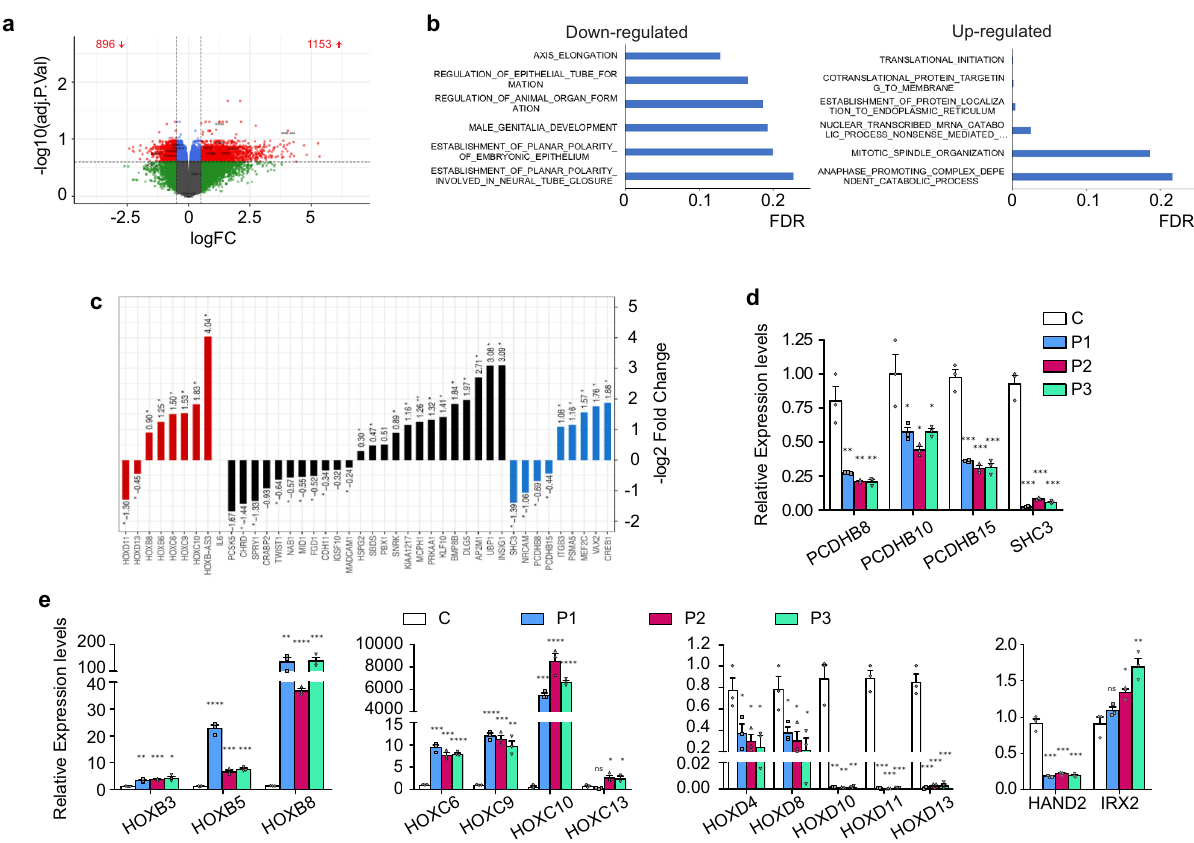
Fig. 3 Genes involved in development and differentiation are deregulated in CdLS patient-derived cells. a Volcano plot representation of gene expression changes between control and CdLS-derived fi broblasts. Signi fi cantly downregulated and upregulated genes are indicated in red. Green, blue, and gray show non-signi fi cant differential genes. b Gene ontology (GO) enrichment analyses reveal biological processes that are downregulated and upregulated in CdLS-derived fi broblasts (blue bars). c Representation of the log-fold changes in expression of genes related to developmental processes (black bars). Genes involved in embryonic system development and differentiation are marked in red, those involved in nervous system development are marked in blue. Two-sided unpaired student ’ s t -test (** p < 0.01; * p < 0.05). d , e The expression levels of some nervous system development genes ( d ) and embryonic development genes ( e ) were analyzed in a control (C, white) and three CdLS patient-derived fi broblasts (P1, blue; P2, purple; P3, green) by reverse transcription-qPCR. The graphs show the amount of transcript of each gene relative to that in the control. Means and SEMs were calculated from biological triplicates. Two-sided unpaired student ’ s t -test (**** p < 0.0001; *** p < 0.001; ** p < 0.01; * p <